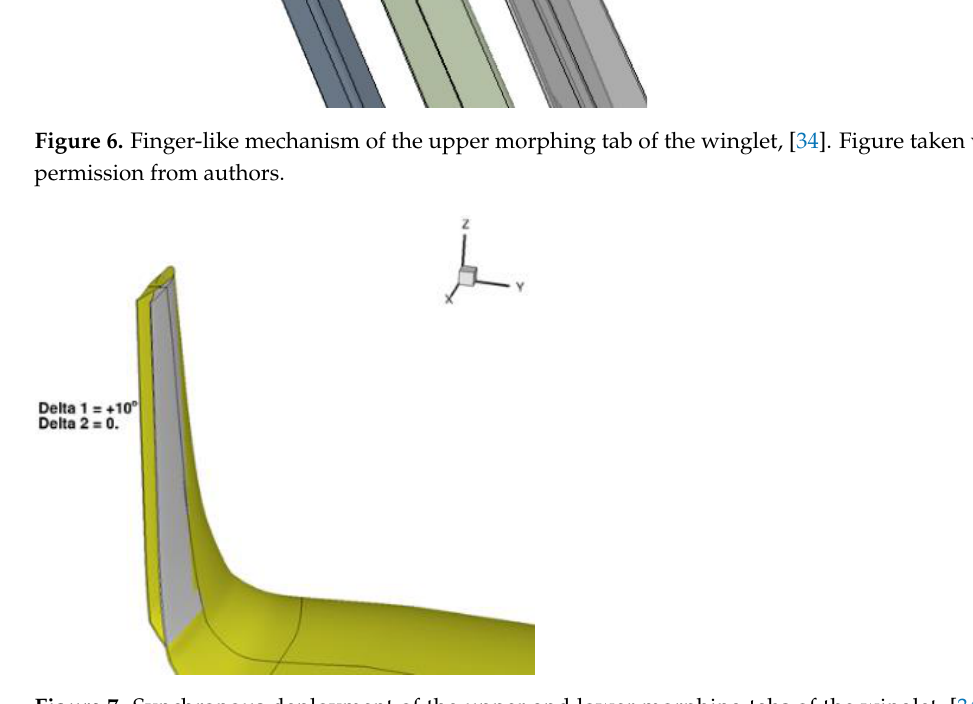
Figure 6. Finger-like mechanism of the upper morphing tab of the winglet, [34]. Figure taken with permission from authors.